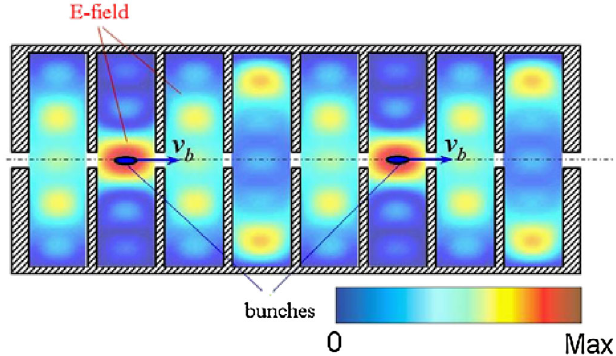
FIG. 1. (Color) Acceleration of moving periodic bunches in uncoupled cavities operating with a superposition of synchro- nized harmonically related eigenmodes.